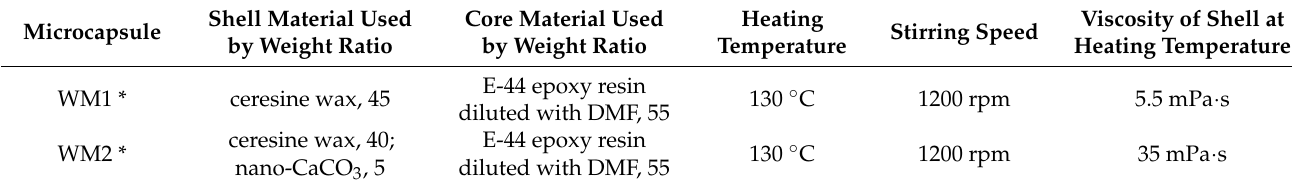
Table 3. Preparation parameters and shell/core weight ratios of microcapsules.